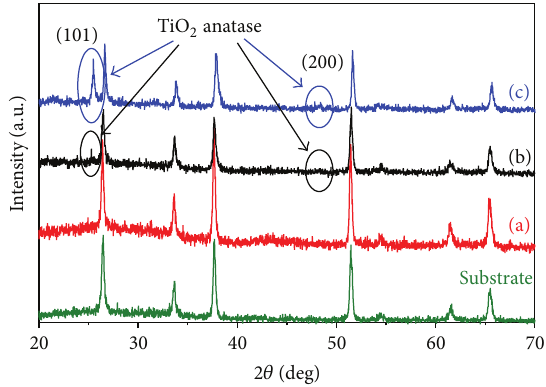
Figure 7: XRD patterns for films deposited at (a) 0.2, (b) 0.6, and (c) 3.5